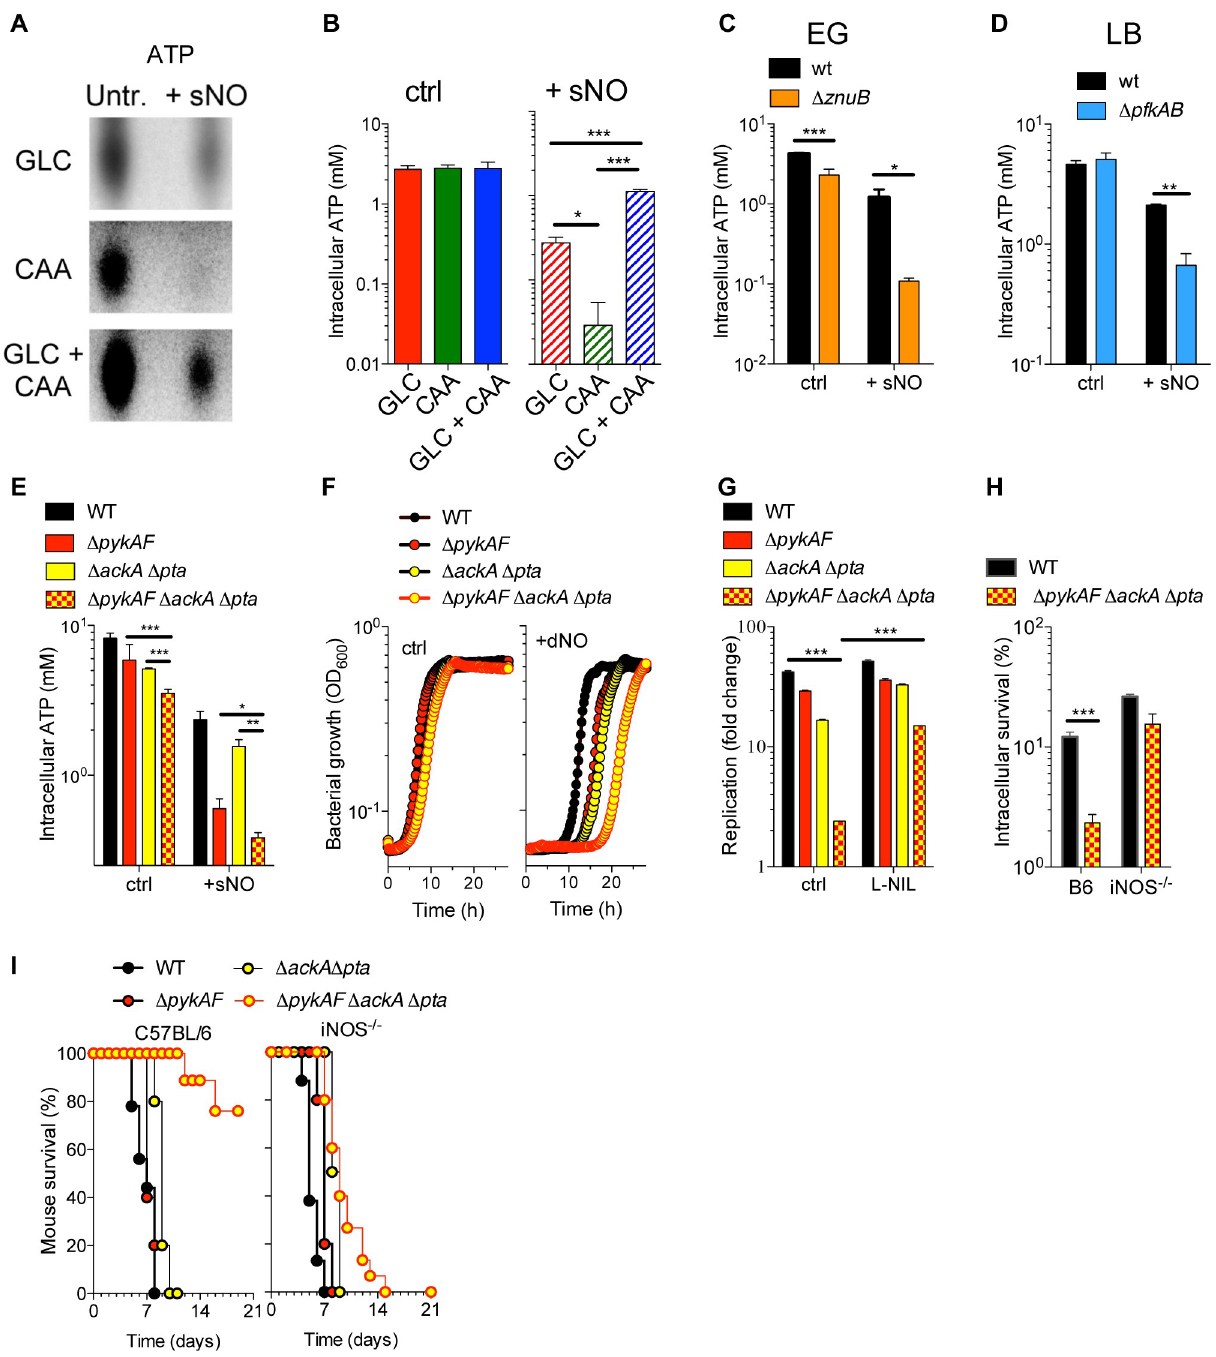
Fig 6. Effects of carbon source on the ATP pool of Salmonella undergoing nitrosative stress. (A) ATP was visualized after TLC analysis of 32 P-labeled Salmonella grown in MOPS minimal media supplemented with either glucose (GLC) and/or casamino acids (CAA). When indicated, the cultures were treated with 750 μ M spermine NONOate (sNO) for 5 min. Images are representative of experiments performed on at least two independent days. (B, C-E) The ATP pools were independently estimated with firefly luciferase. The bacteria were grown in EG (C and E) or LB broth (D). Select bacteria were treated with 750 μ M sNO for 5 min (N = 6, mean ± S.E.M.). � , �� , ��� p < 0.05, 0.01, 0.001, respectively, as determined by one-way or two-way ANOVA. (F) Growth of the indicated Salmonella strains after treatment with 1 mM DETA NONOate (dNO) in EG media. (G) Intracellular growth of Salmonella in J774 cells 20 h after infection. Some of the specimens were treated with 500 μ M L-NIL. (H) Intracellular survival of Salmonella in periodate-elicited macrophages from C57BL/6 or iNOS -/- mice (N = 4–5, mean ± S.D.). ��� , p < 0.001 as determined by two-way ANOVA. (I) Survival of C57BL/6 or iNOS -/- mice after i.p. inoculation of 100 CFU of the indicated Salmonella strains. N = 9–15; � p < 0.05, WT vs. Δ pykAF Δ ackA Δ pta in C57BL/6 mice as determined by logrank analysis; all other comparisons to WT were not statistically